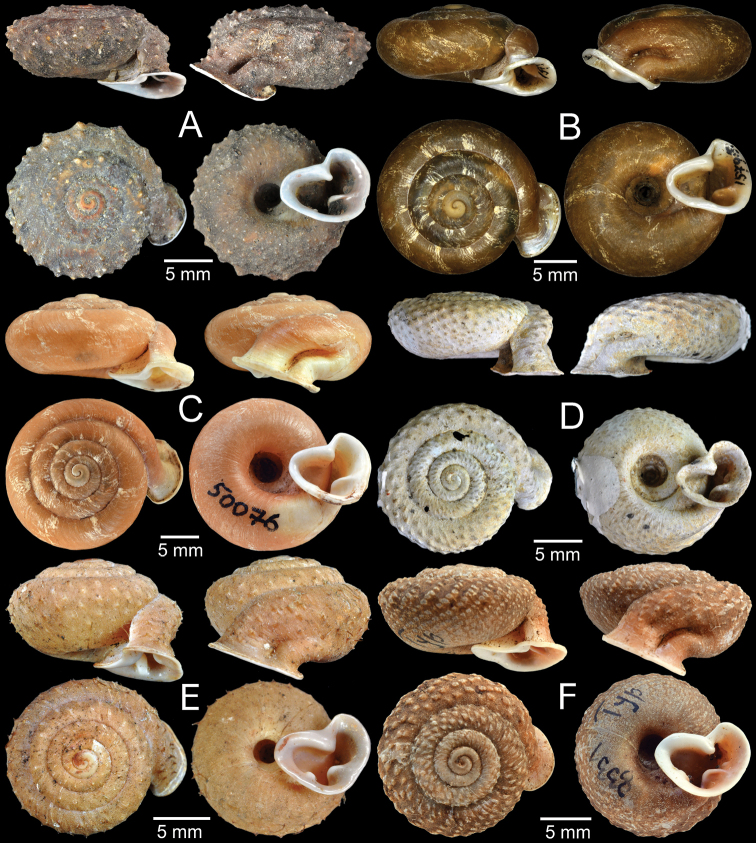
AMoellendorffia
loxotata
exasperata, syntype MNHN-IM-2000-34940 B, CMoellendorffia
hensaniensisB lectotype NHMW 15795 and C paralectotype SMF 50076/1 DMoellendorffia
loxotata, syntype MNHN-IM-2000-2071 EMoellendorffia
messageri, syntype MNHN-IM-2000-1939 FMoellendorffia
trisinuata
sculpticoncha, lectotype SMF 8331/1. Photo: S Schnedl (B).